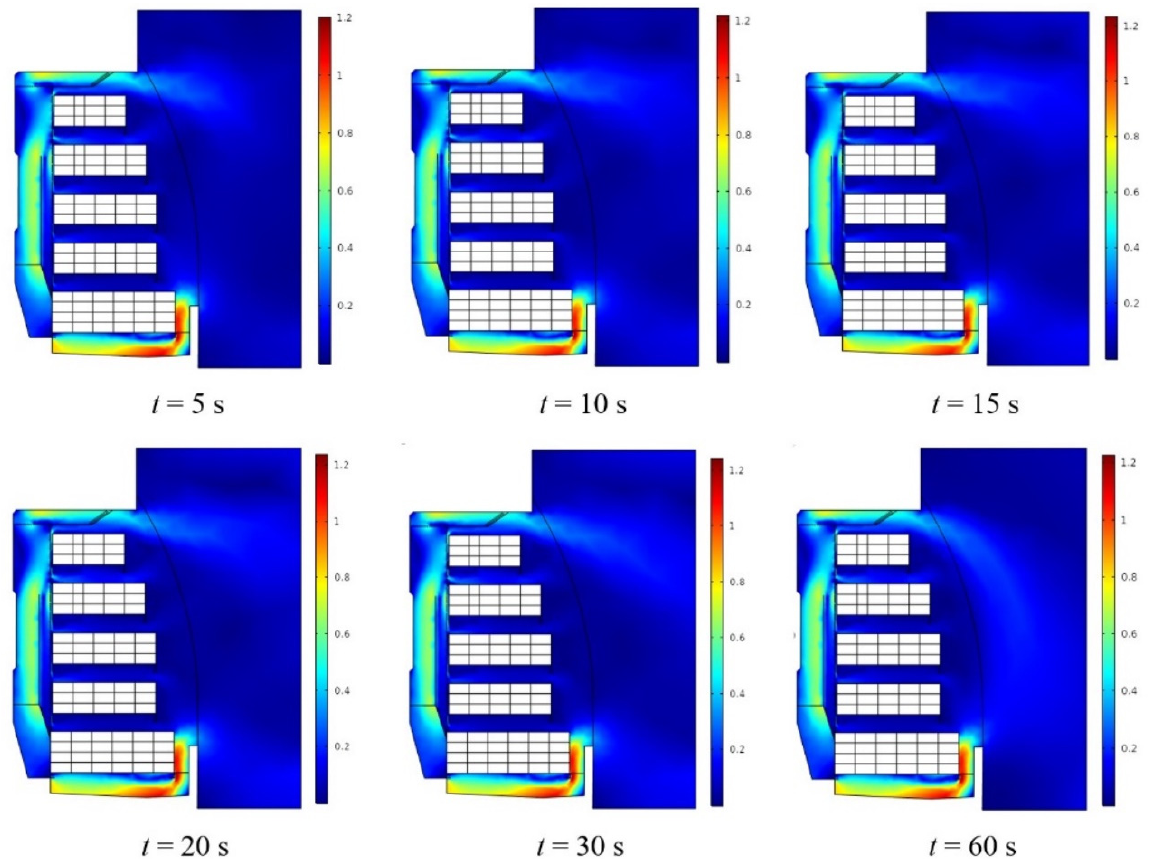
Figure 6. Air velocity (m/s) distribution in the middle plane of the unmodified cabinet.